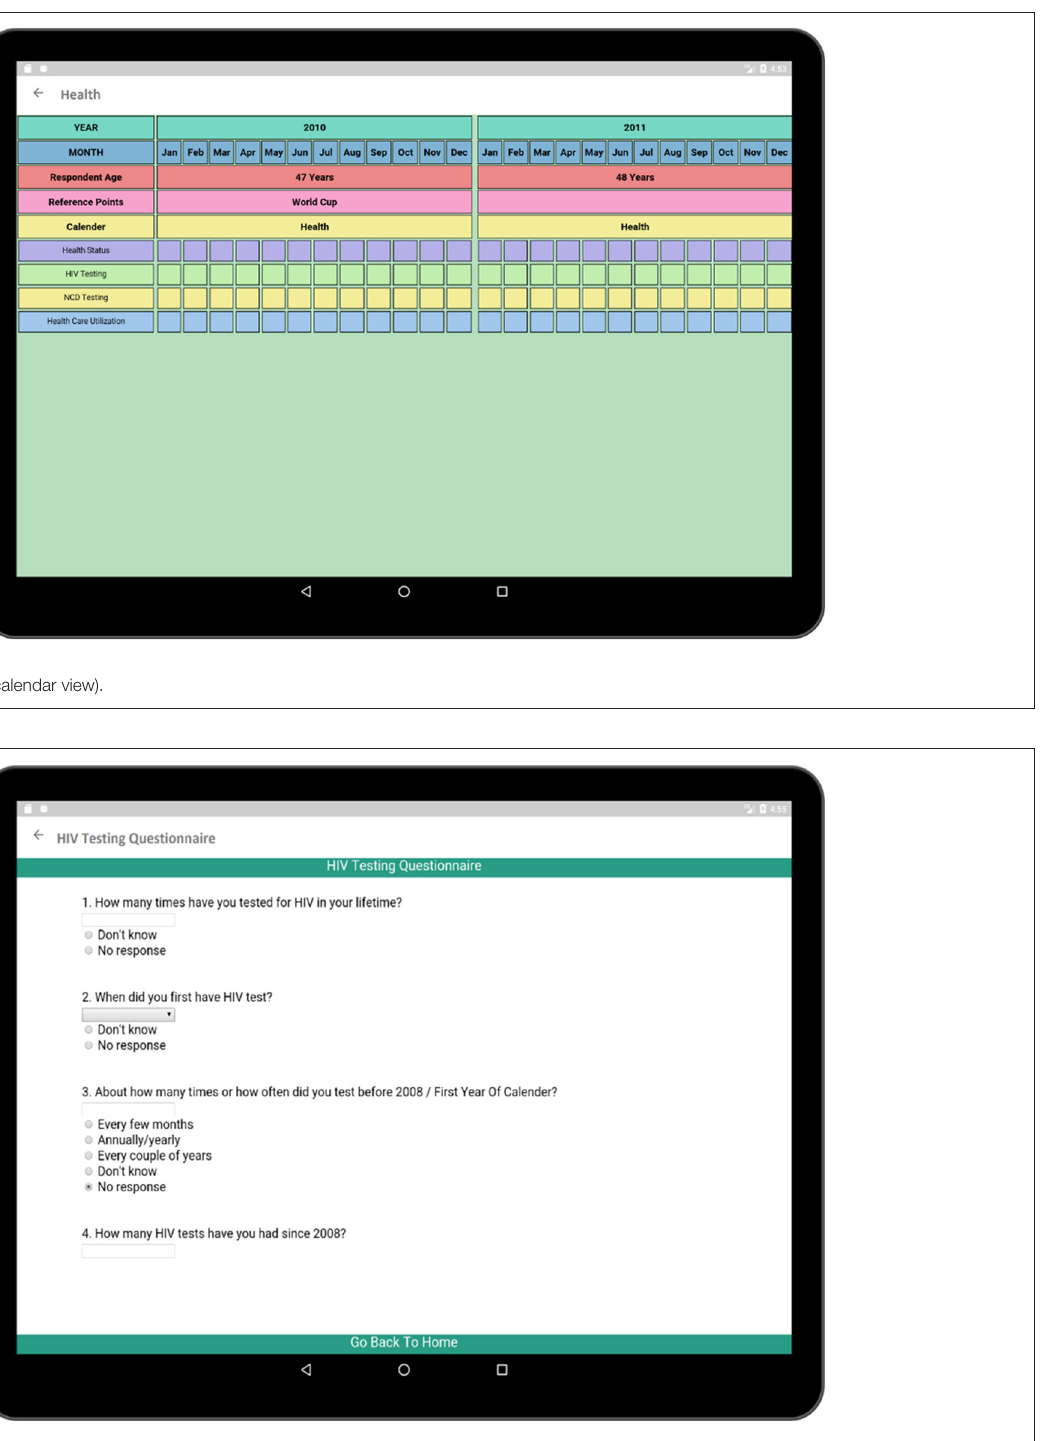
FIGURE 10 | Questionnaire for overall HIV testing